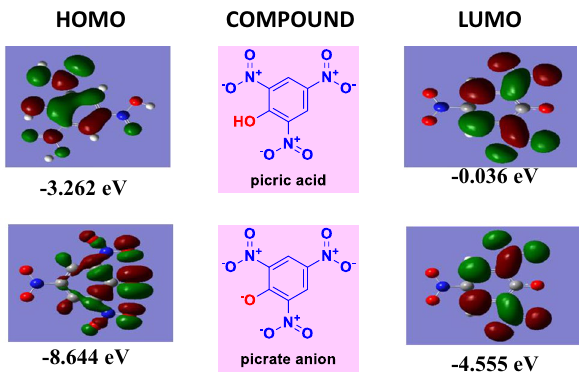
Figure 8. HOMO–LUMO of picric acid and picrate anion.